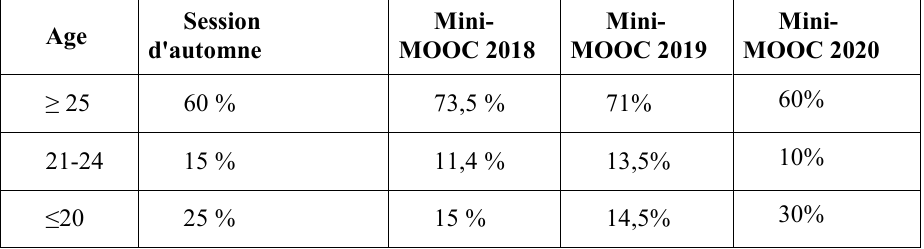
Tableau 2. Nombres d’inscrits pour les session Mini-MOOC. Tableau 5. Répartition des inscrits au Mini-MOOC pour les sessions